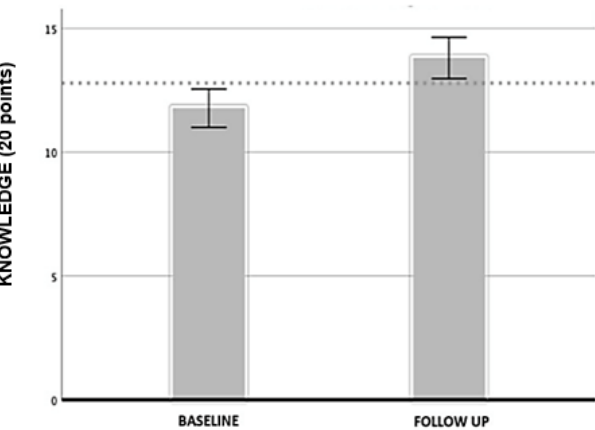
Figure 3. Changes on the cycling knowledge at baseline and at follow up on the cycling group.